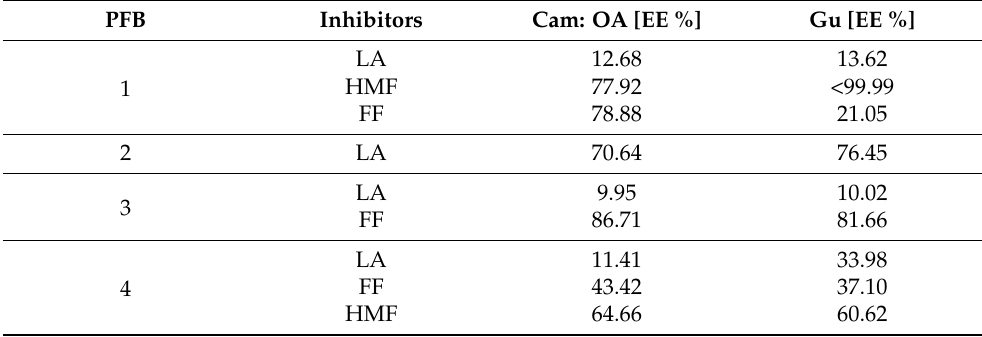
Table 6. The extraction efficiency of FF, HMF, and LA from real post-fermentation broths (PFB) using Cam: OA (1:1) and